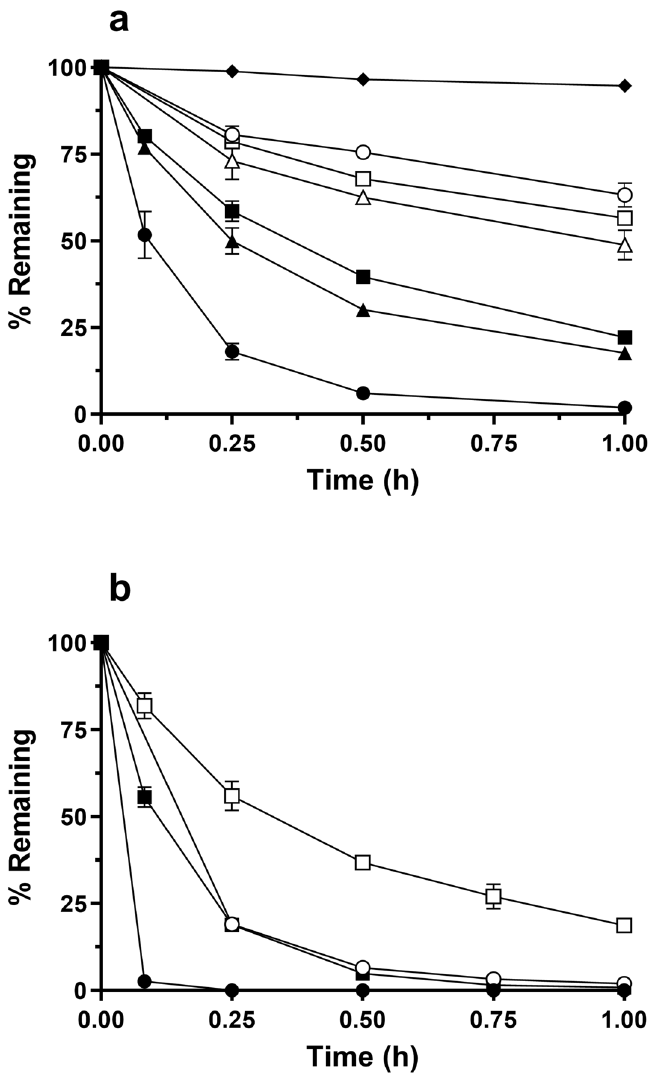
Figure 7. Stability of EC2491 in liver microsomes. Percent intact EC2491 after incubating 1 µM in ( a ) buffer (filled diamond), liver microsomes (rat, open circle; dog, open square; and human, open triangle) and liver microsomes + NADPH (rat, filled circle; dog, filled square; and human, filled triangle) and ( b ) liver microsomes (+ NADPH) from dexamethasone treated rat (filled circle), corn-oil treated rat (open circle), rifampin treated dog (filled square) or corn-oil treated dog (open square). Points , average of 2 samples; bars,